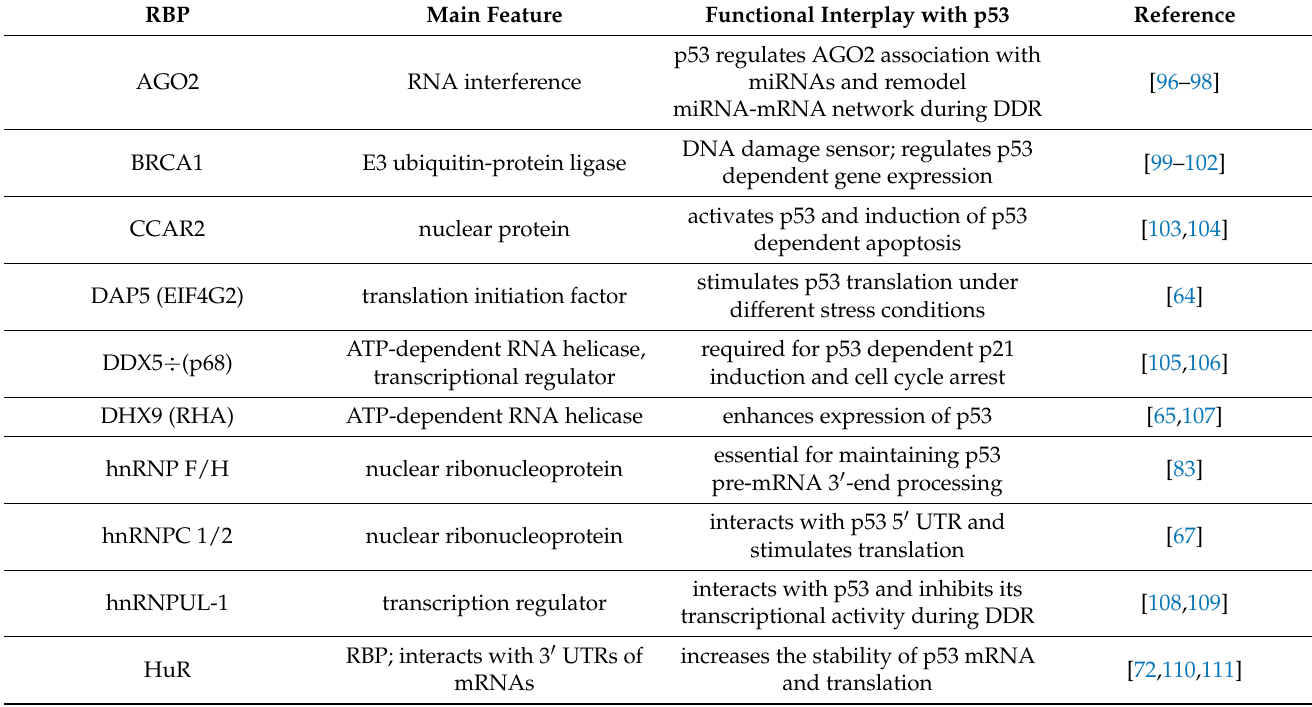
Table 2. Overview of RNA binding proteins (RBPs) linked with the DDR and functional interplay with p53. RBP Main Feature Functional Interplay with p53